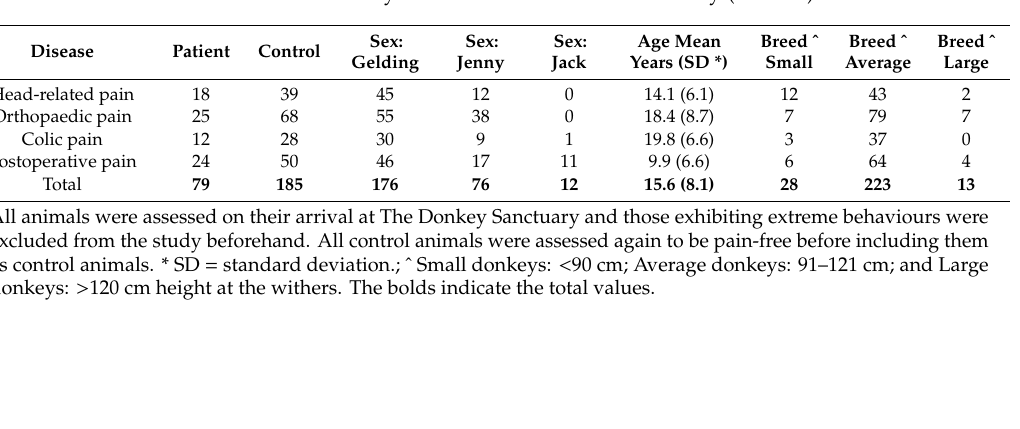
Table 1. Data of donkeys that were included in the study ( n =